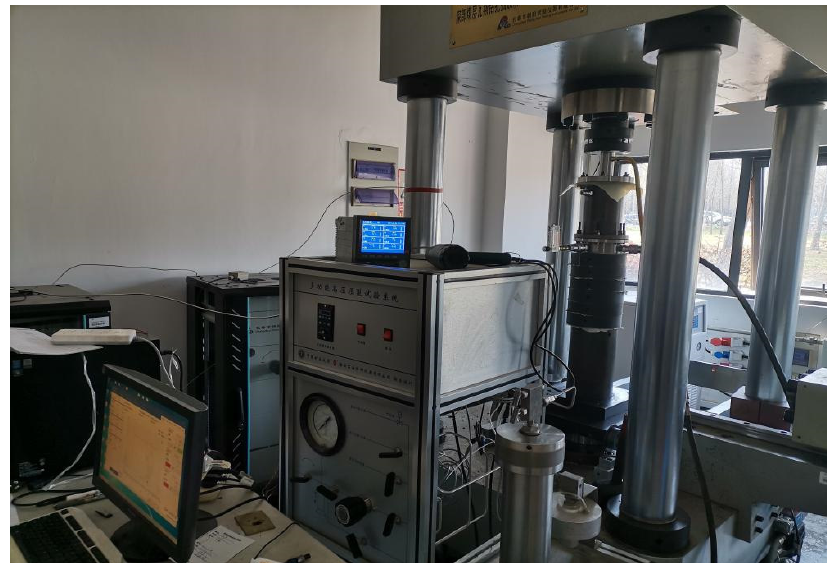
Figure 3. TAWD-2000 coal-rock mechanics-seepage test system.